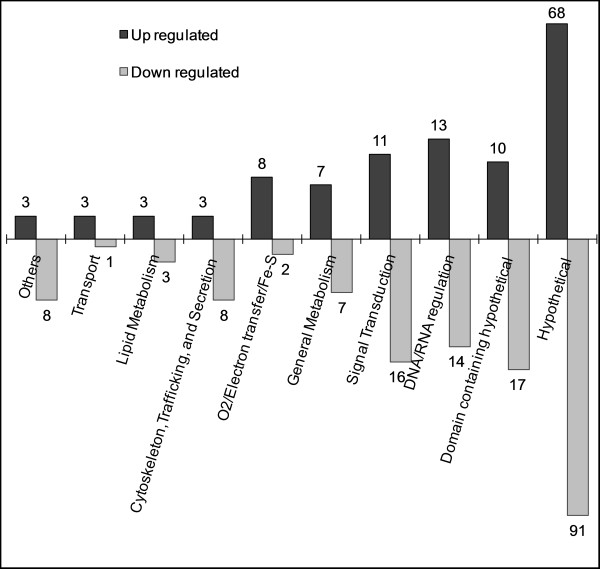
Functional distribution of differentially expressed genes upon L-cysteine deprivation. Genes were grouped according to putative functions inferred from the respective annotations. The exact number of changed transcripts is shown beside each column.